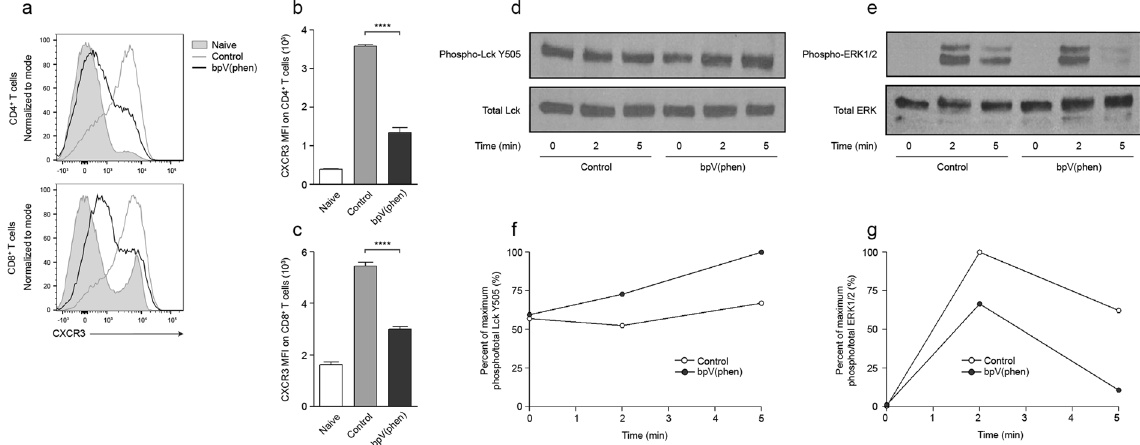
Figure 7. PTP inhibition prevents the upregulation of CXCR3 and attenuates TCR-mediated signalling in splenic T cells. ( a ) Representative histograms of CXCR3 expression on bpV(phen)-treated CD4 + and CD8 + T cells and the mean fluorescence intensity (MFI) of CXCR3 on bpV(phen)-treated ( b ) CD4 + and ( c ) CD8 + T cells following anti-CD3/anti-CD28 stimulation. **** P < 0.0001 using a one-way ANOVA and Tukey’s multiple comparisons test. The cumulative average of 3 independent experiments is shown. Representative western blots of ( d ) phospho- and total Lck Y505 and ( e ) phospho- and total ERK1/2, and densitometry graphs of ( f ) phospho-LckY505 and ( g ) phospho-ERK1/2. The western blots and densitometry graphs are representative of 3 independent